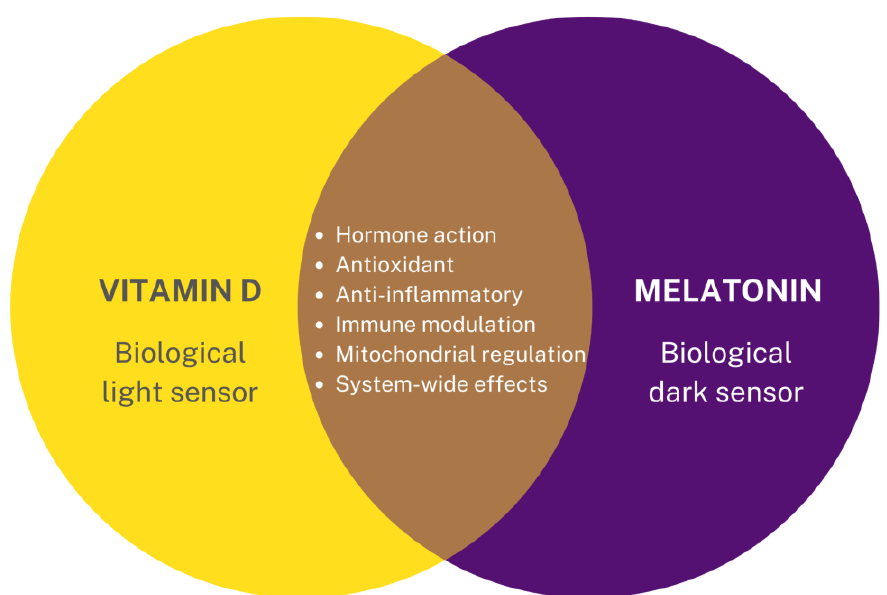
Figure 3. Vitamin D and melatonin as light and dark sensors with shared functions. Graphic created using https://Canva.com accessed 27 July 2022.